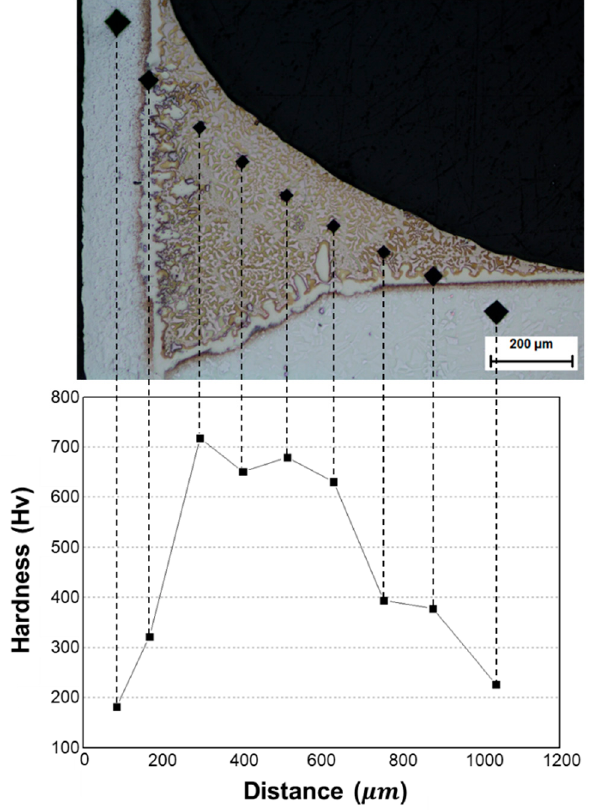
Figure 5. Microhardness profile across the brazed region.